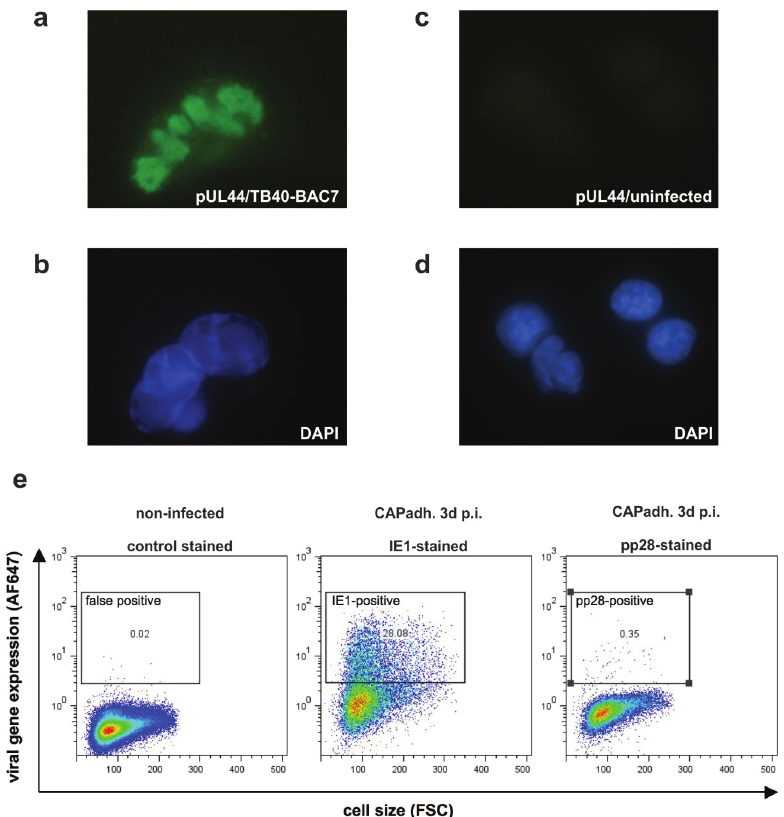
Figure 4. Analysis of nuclear replication compartment formation and of late gene expression in CAP cells. ( a ) analysis of nuclear replication compartment formation by indirect immunofluorescence staining of pUL44 localization in CAP adh. , infected with TB40/E-BAC7 at an m.o.i. of 0.5 for five days; ( b ) DAPI staining of the nuclei of the cells from panel a; ( c ) staining of uninfected cells with a pUL44 specific antibody; ( d ) DAPI staining of the nuclei of the cells from panel c; ( e ) FACS analysis of IE1 and pp28 expression in CAP adh. . Cells were infected with TB40/E-BAC4deltaUL5-9luc at an m.o.i. of 2. At 1.5 h after infection, the inoculum was removed. Cells were then incubated with 0.14 M NaCI, exposed to 0.1 M glycine (pH 3.0) for 1 min to inactivate residual virus and were subsequently washed with maintenance medium. Three day after infection, cells were collected, fixed with ethanol, and incubated with specific monoclonal antibodies. Cells were then incubated with an AF647 labeled anti-mouse specific secondary antibody. Unspecific binding of primary antibodies was excluded by incubation of infected cells with a mouse isotype control. Viral protein expression was measured by FACS. Results were depicted in viral gene expression against total cell